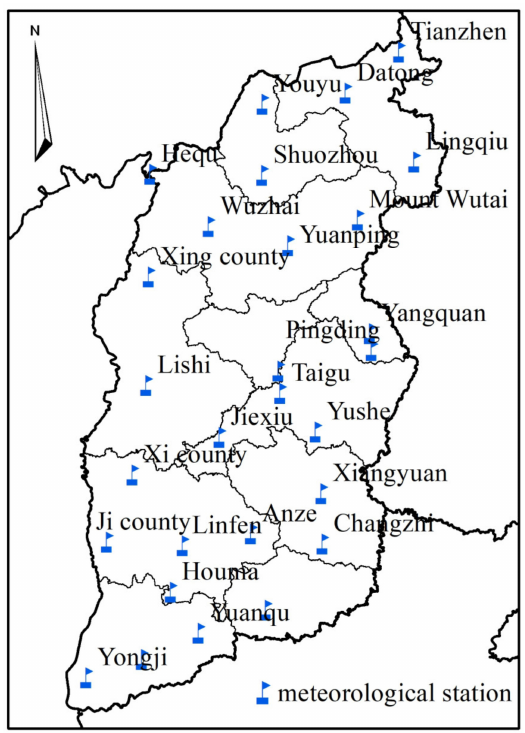
Figure 2. Study area and meteorological